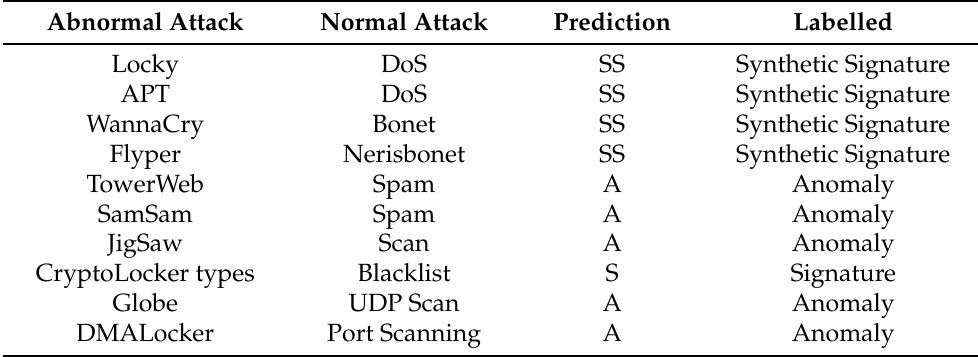
Table 8. The data structure of